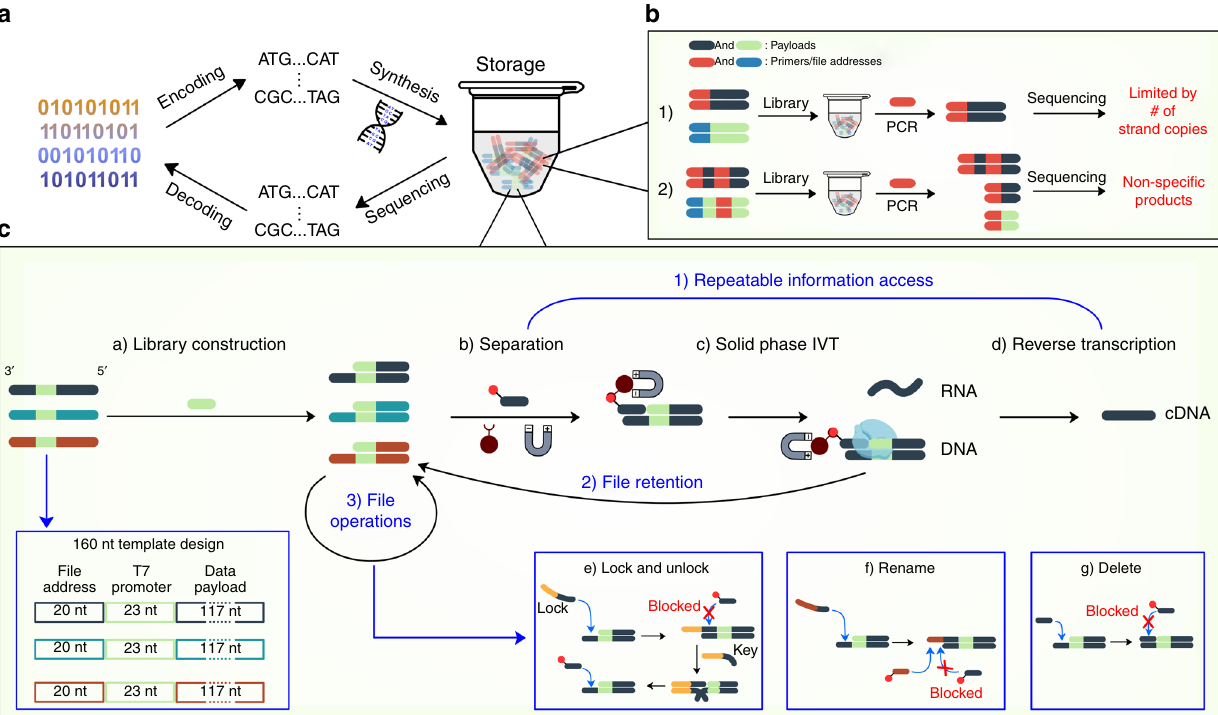
Fig. 1 Molecular technologies unlock dynamic operations for DNA storage. a The generic framework for DNA-based storage systems includes encoding of digital information to nucleotide sequences, DNA synthesis and storage, DNA sequencing, and decoding the desired information. b Schematic of challenges faced by PCR-based fi le access. c Schematic of DORIS (Dynamic Operations and Reusable Information Storage). ss-dsDNA strands enable repeatable information access through non-PCR-based magnetic separation, in vitro transcription, reverse transcription, and the return of separated fi les to the database. Additionally, the overhangs of ss-dsDNAs enable in-storage fi le operations including lock, unlock, rename, and